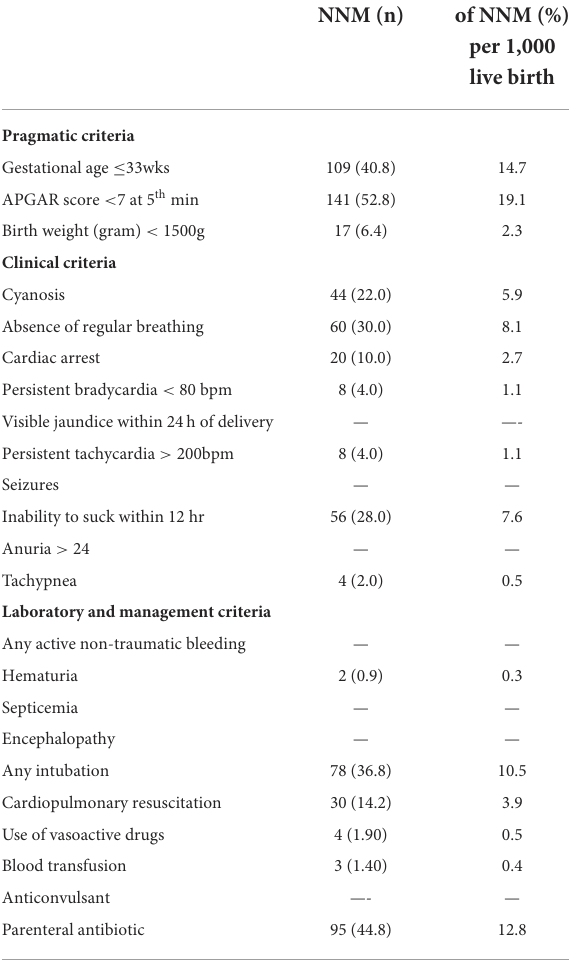
TABLE 5 Criteria used for the identification of neonatal near miss, North Shewa zone, Oromia region, Ethiopia, 2021.